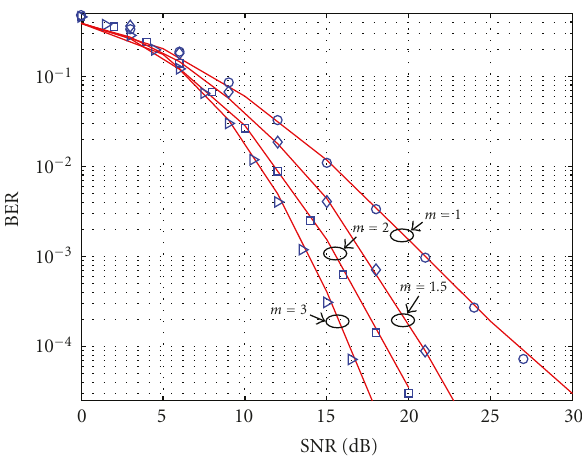
Figure 6: BER versus SNR performance of DDAAF cooperative system over Nakagami- m channels with uniform ◦ and optimized Δ power distribution to minimize the BER, σ 2 = 10. σ 2 r , d